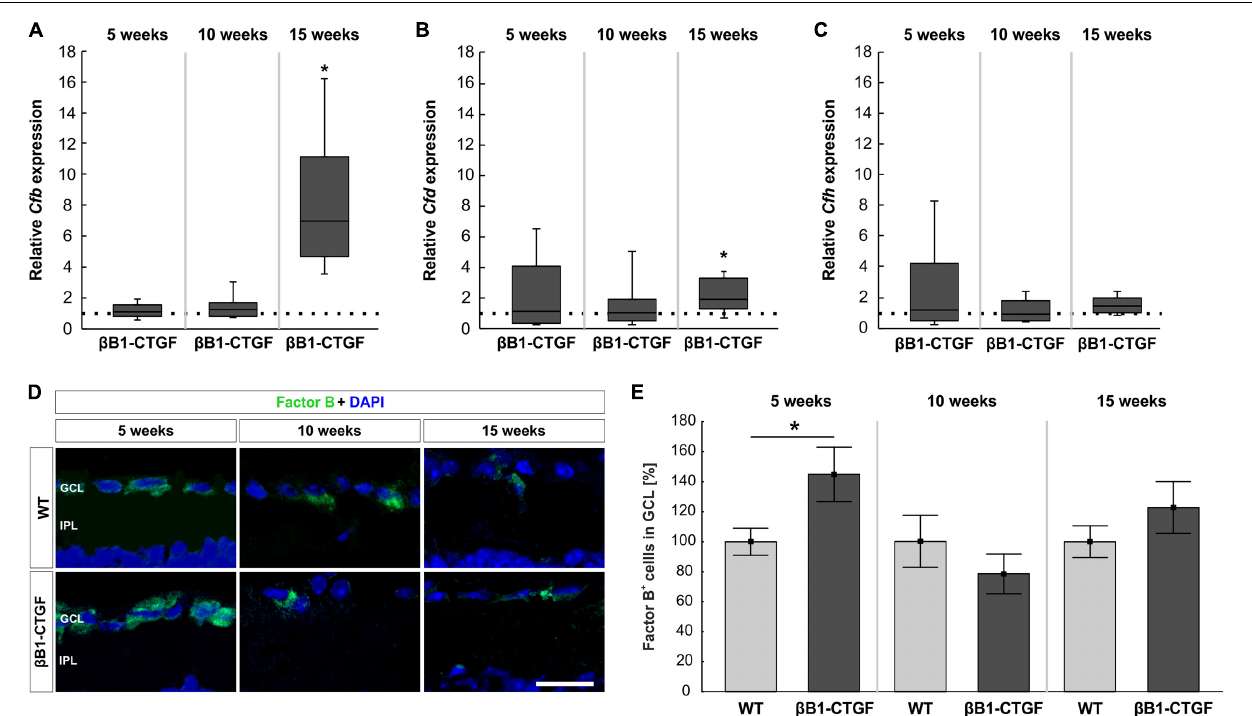
FIGURE 3 | Activation of the alternative pathway. (A) At 5 and 10 weeks of age, no alterations in Cfb mRNA levels were noted. At 15 weeks, a significant upregulation of Cfb mRNA levels was revealed ( p = 0.01). (B) RT-qPCR analyses showed no changes in Cfd mRNA levels in 5-and 10-week-old β B1-CTGF mice. In contrast, Cfd mRNA levels were significantly upregulated in 15-week-old transgenic mice ( p = 0.03). (C) The mRNA levels of Cfh were not altered at 5, 10, and 15 weeks. (D) Retinae were stained with an antibody against Factor B (green) and cell nuclei were labeled with DAPI (blue) at all ages. (E) The number of Factor B + cells in the ganglion cell layer was significantly higher in β B1-CTGF animals compared to WT ( p = 0.046). No changes were seen at 10 and 15 weeks. Values for RT-qPCR are median ± quartile ± minimum/maximum ( n = 5–7/group). The dotted line in panels (A–C) represents the relative expression of the WT group. Values for immunohistology are mean ± SEM ( n = 7–9/group). GCL, ganglion cell layer; IPL, inner plexiform layer. Scale bar: 20 µ m. * p <